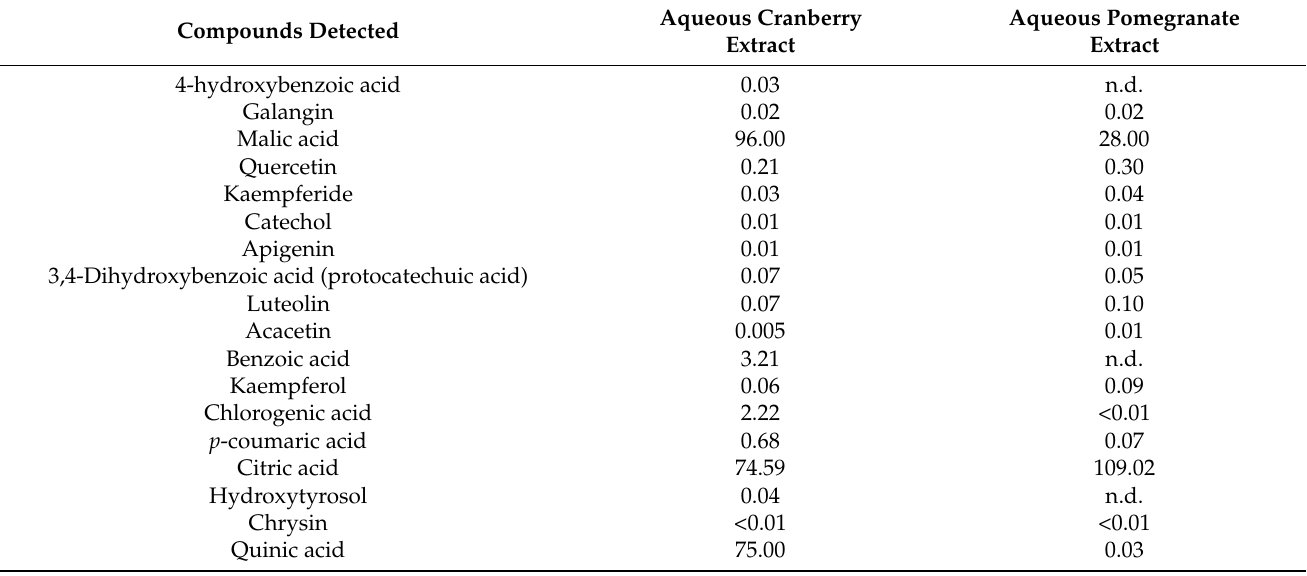
Table 4. Chemical composition of aqueous extracts of cranberry and pomegranate expressed in mg/L. Aqueous Cranberry Aqueous Pomegranate Compounds Detected Extract Extract 4-hydroxybenzoic acid 0.03 n.d. Galangin 0.02 0.02 96.00 28.00 0.21 0.30